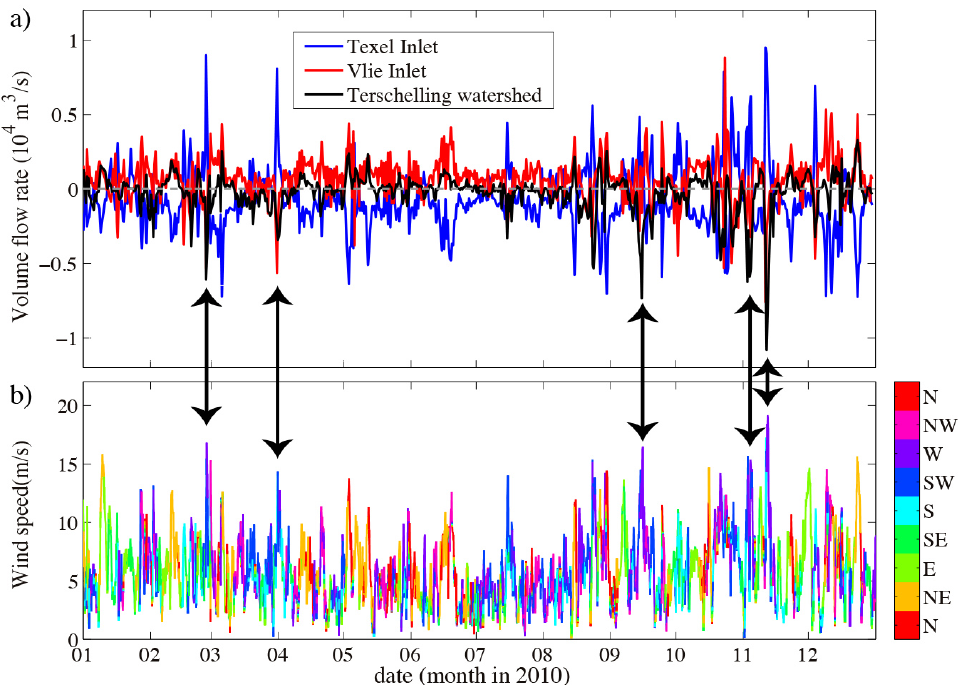
Figure 14. As Fig. 13, for the year